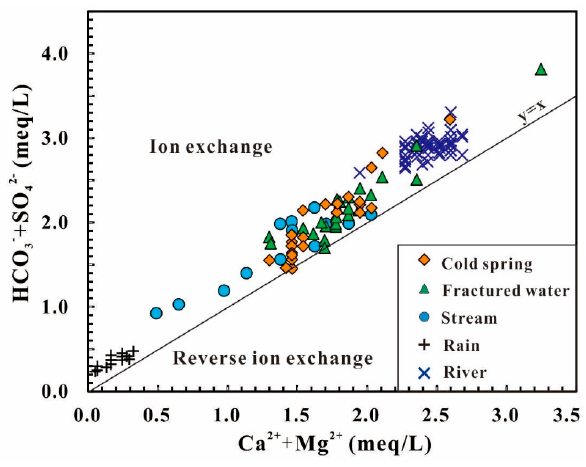
Figure 7. HCO 3 − + SO 42 − versus Ca 2+ + Mg 2+ diagram.